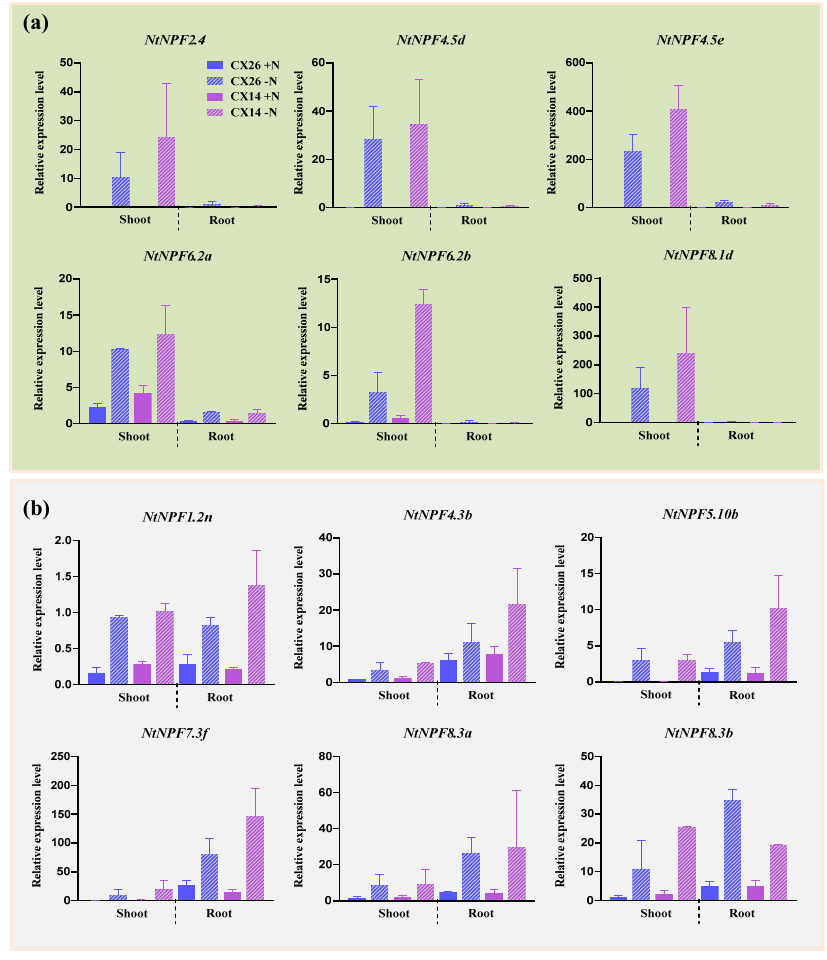
Figure 10. The expression profiles of the 12 NtNPFs in different tissues under nitrogen (N) stress by qRT-PCR: ( a ) genes with high expression levels in shoot; ( b ) genes with high expression levels in root. Seedlings at 20 days old were exposed to an N-free nutrient solution for seven days. The roots and shoots were sampled separately for RNA extraction. +N, 6 mM N; − N, 0 mM N.